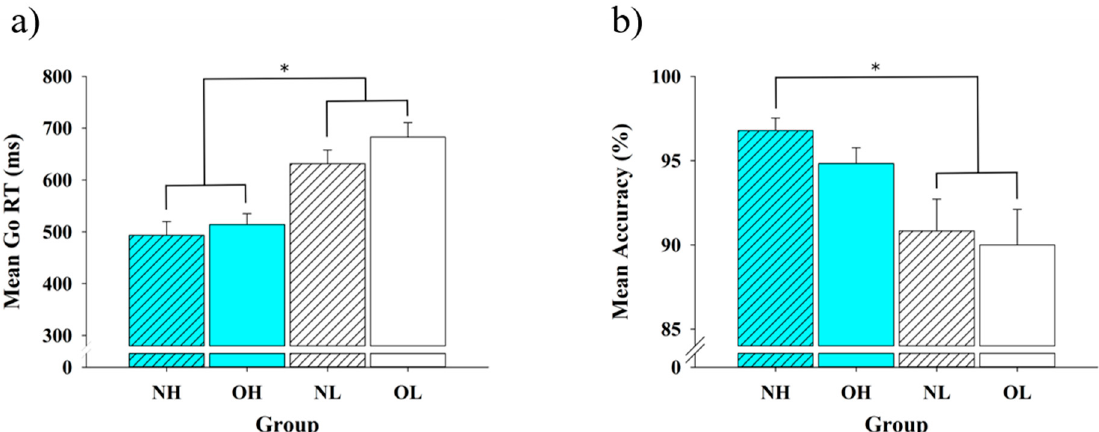
Figure 1. A comparison of the ( a ) response time (RT) and the ( b ) accuracy (means ± SE) on the Stop-Signal task during go-trials for the four groups. NH = High CRF with normal weight; OH = high CRF with obesity; NL = low CRF with normal weight; and OL = low CRF with obesity. * p < 0.05.